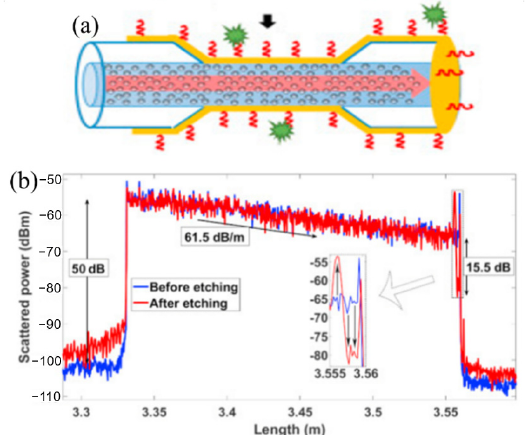
Figure 14. ( a ) The schematic diagram of an etched MgO-based nanoparticle-doped fiber sensor coated by Au film. ( b ) The typical scattering traces with backscattered power before etching and after etching. Reprinted with permission from [205].